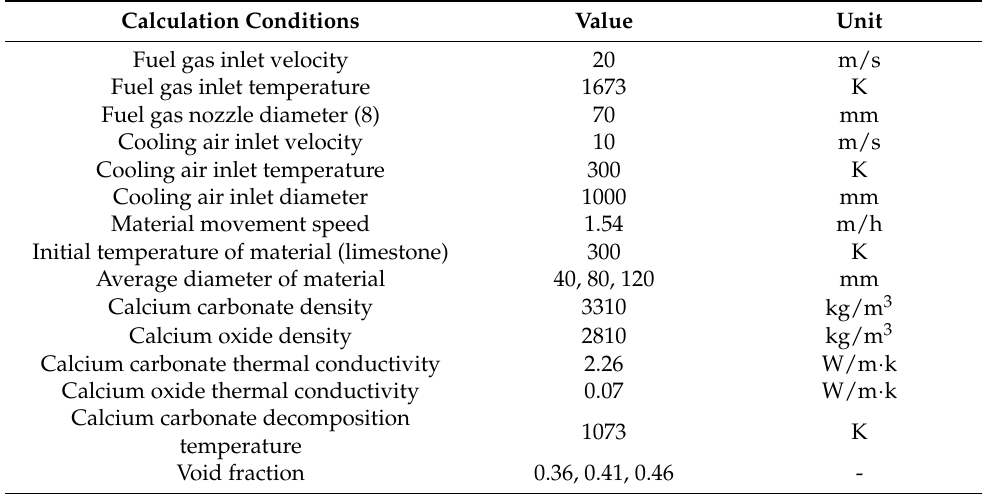
Figure 2. Schematic diagram of the operating procedure of the PFR lime kiln. Table 1. Calculation